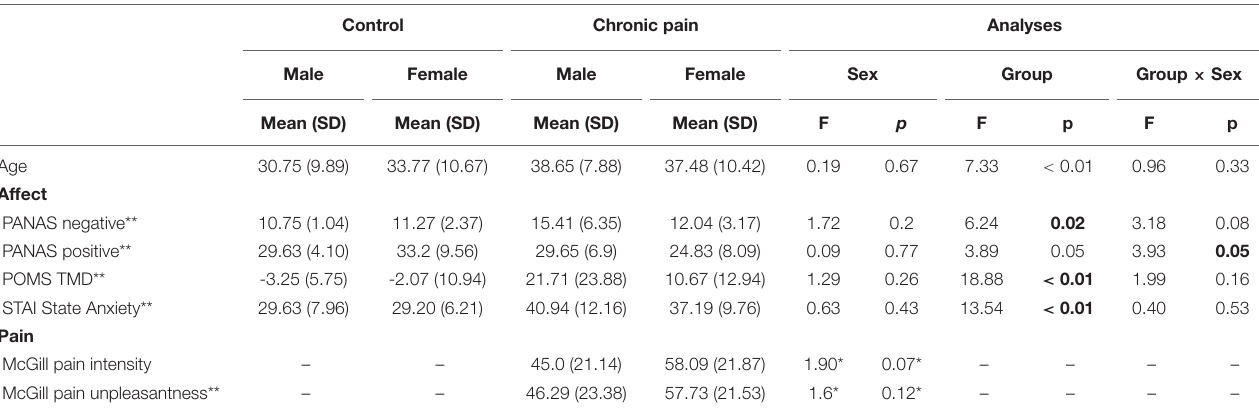
TABLE 1 | Baseline